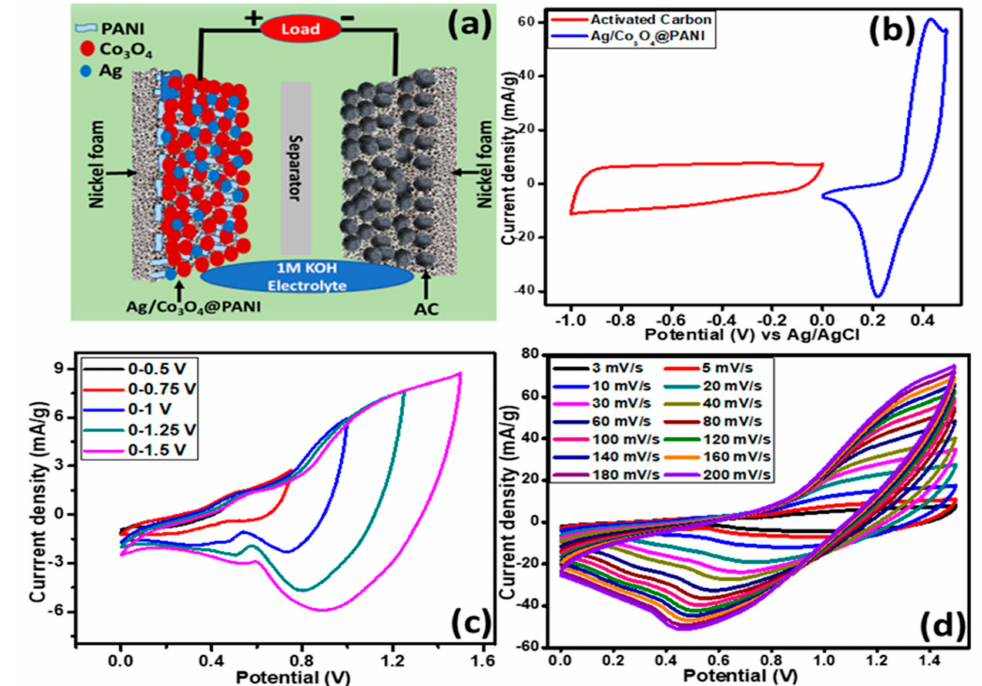
Figure 11. ( a ) Graphical design of the assembled supercapattery incorporating battery-type ternary nanocomposite, Ag / Co 3 O 4 @PANI, as a positive electrode, ( b ) CVs of activated carbon (AC) electrode at 5 mV s − 1 and Ag / Co 3 O 4 @PANI electrode at scan rate of 3 mV s − 1 in a three electrode cell system in 1 M potassium hydroxide (KOH), ( c ) CV curves of assembled Ag / Co 3 O 4 @PANI // AC device performed at diverse potential windows in 0.1 M KOH, and ( d ) CV curves of Ag / Co 3 O 4 @PANI // AC supercapattery at various scan rates from 3 to 200 mV s − 1 .